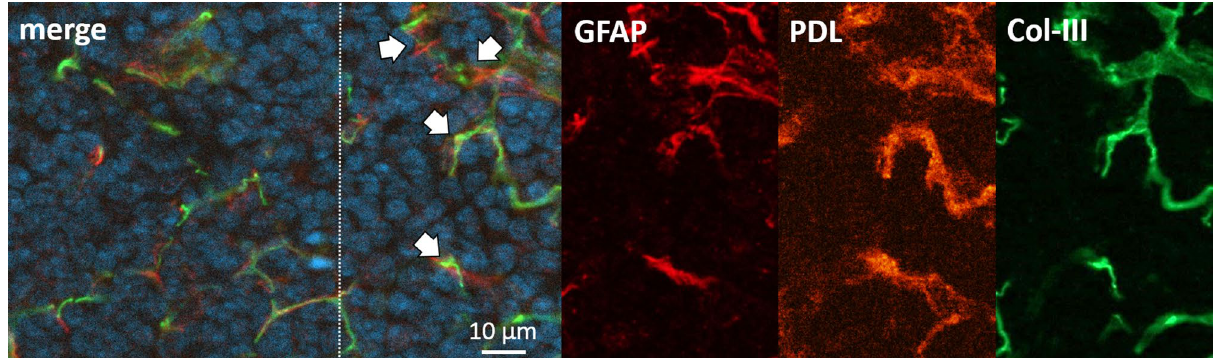
Figure 3. T-cell area of cervical lymph node. Immunohistochemical co-staining with polyclonal anti-GFAP antibody (DAKO) in red (directly conjugated), podoplanin (orange) and Col-III (directly conjugated, green). DAPI for nuclear staining in blue. Colocalization of GFAP, podoplanin and Col-III is abundantly found (arrows).